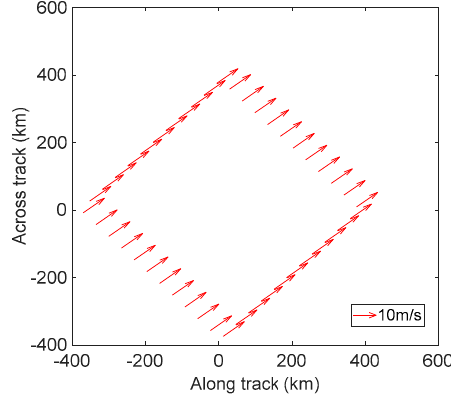
Figure 2. Uniform wind field at the location covered by the radar beam footprint.